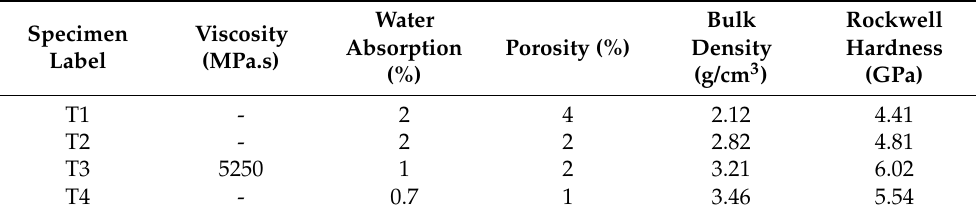
Table 11. The results of viscosity and mechanical properties at different calcining temperatures. Specimen